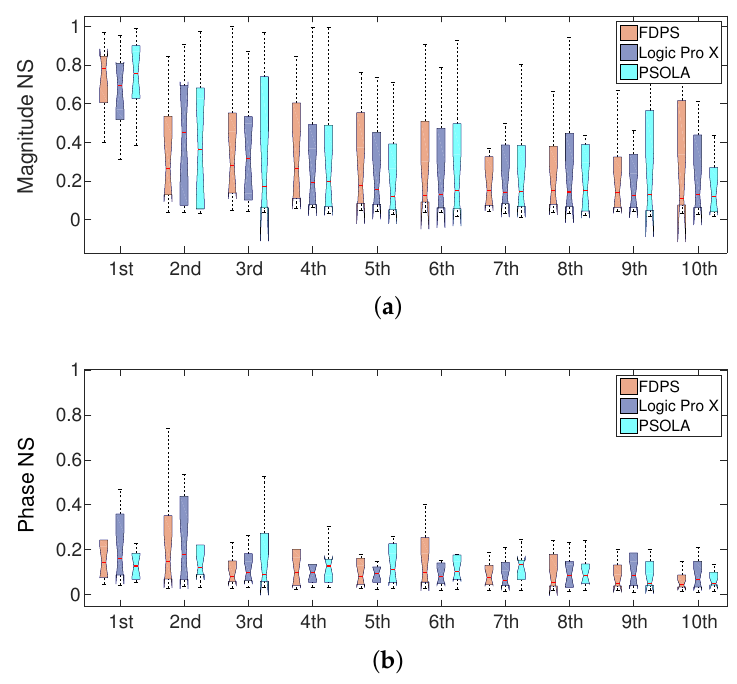
Figure 11. Normalized similarity (NS) of the 10 first harmonic peaks. ( a ) Magnitude of the peaks; ( b ) phase of the harmonic